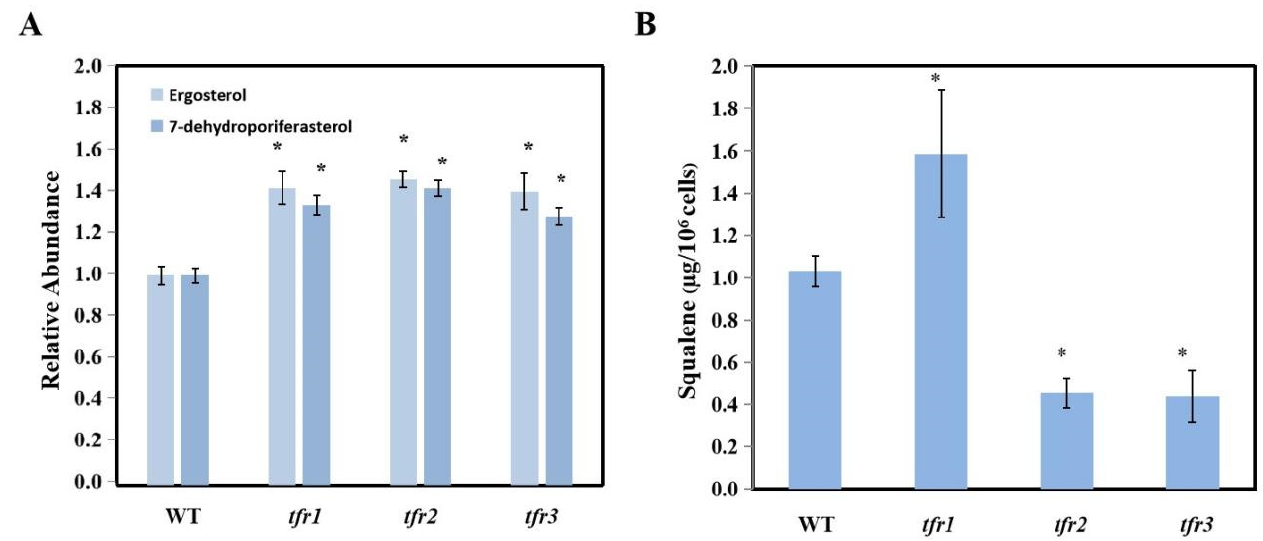
Figure 3. ( A ) Sterols and ( B ) squalene content. Total lipid was extracted from log-phase cultures. All data are means ± SD of three biological replicates. Significant differences between the wild type (WT) and the mutants within the same condition are indicated by asterisks (*) ( p < 0.05).